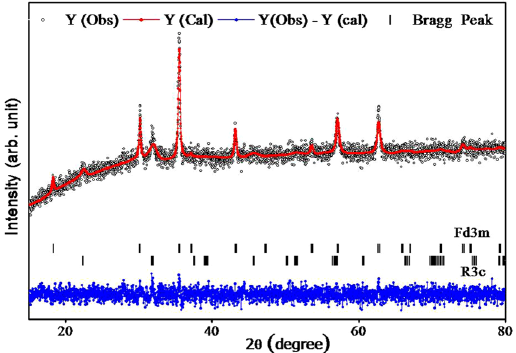
Figure 2. Rietveld refinement of CBF for x = 0.2 samples (dotted black lines are from Fd3m space group spinel phase and blue lines are due to R3c space group of perovskite